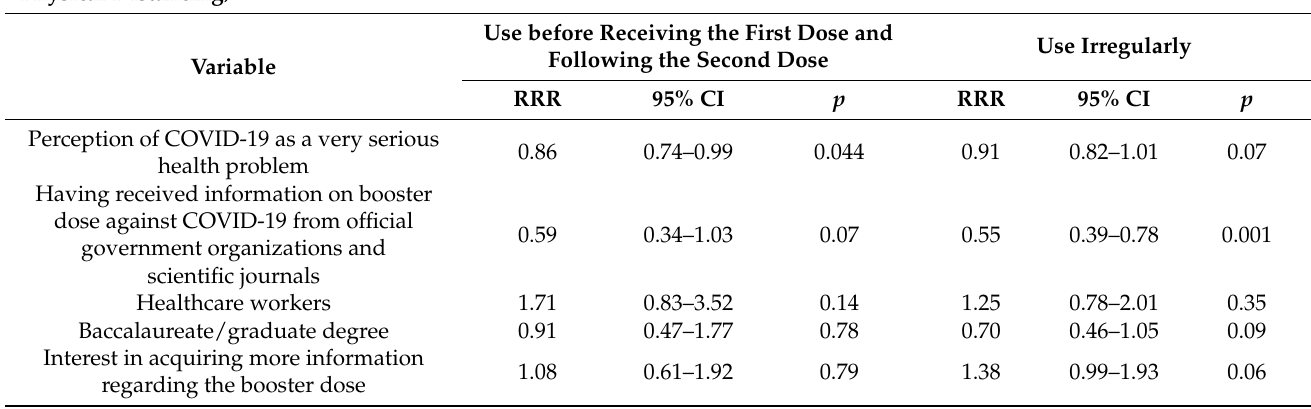
Table 4. Predictors of the third outcome of interest using multinomial logistic regression